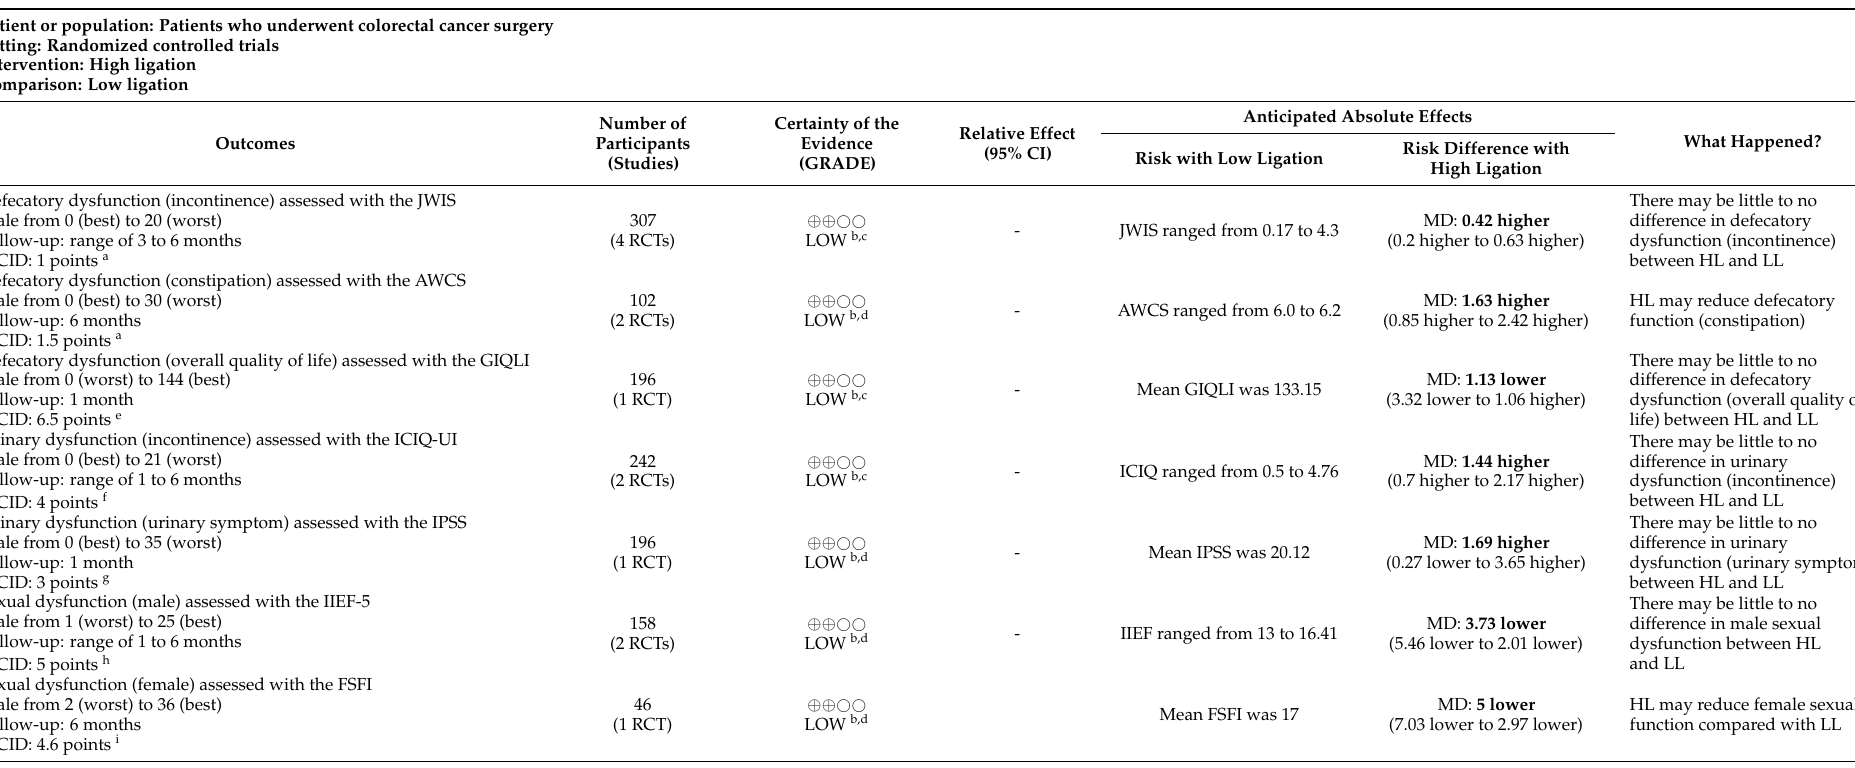
Table 3. Summary of findings: defecatory, urinary, and sexual dysfunction between high ligation and low ligation in colorectal cancer surgery